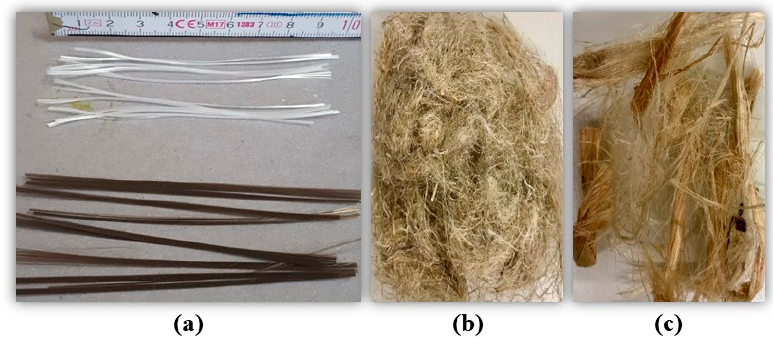
Figure 1. Applied reinforcement fibers: ( a ) Glass (white) and Basalt (black) fibers; ( b ) Flax fibers; ( c ) Kenaf fibers.